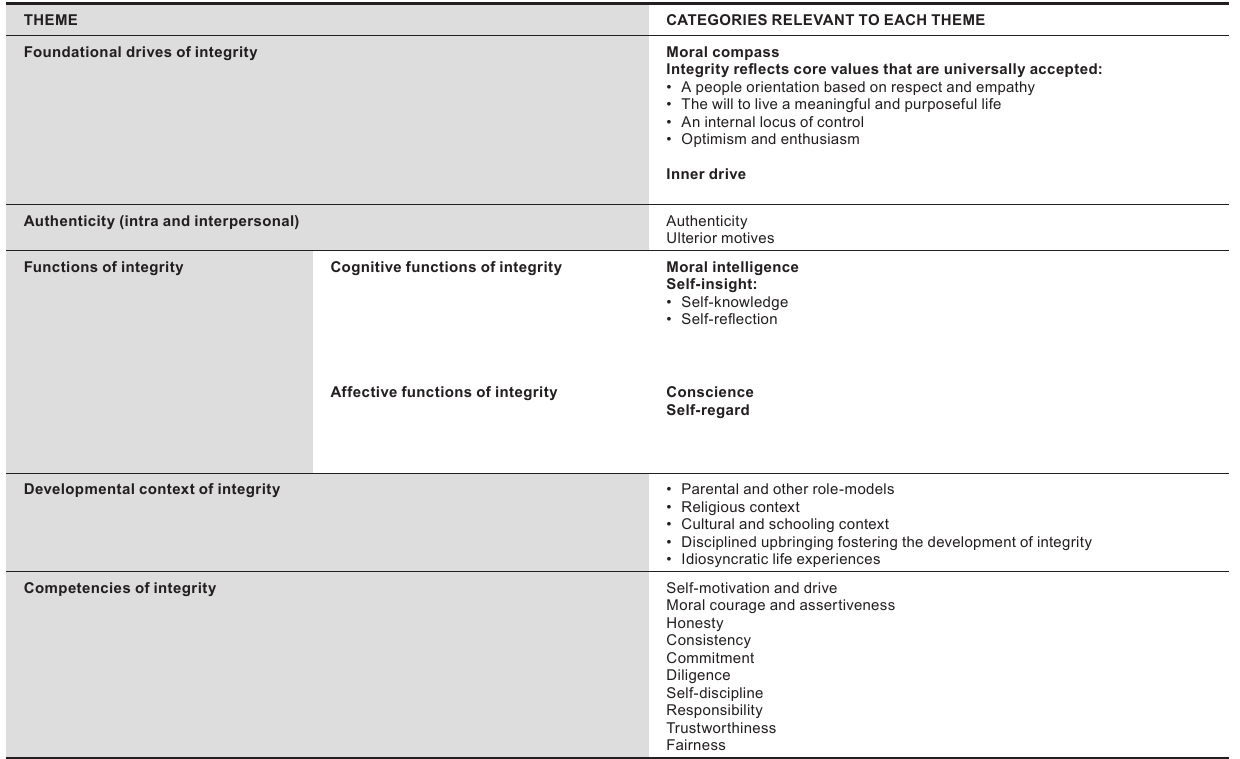
Table 1 Grouping of categories into five core